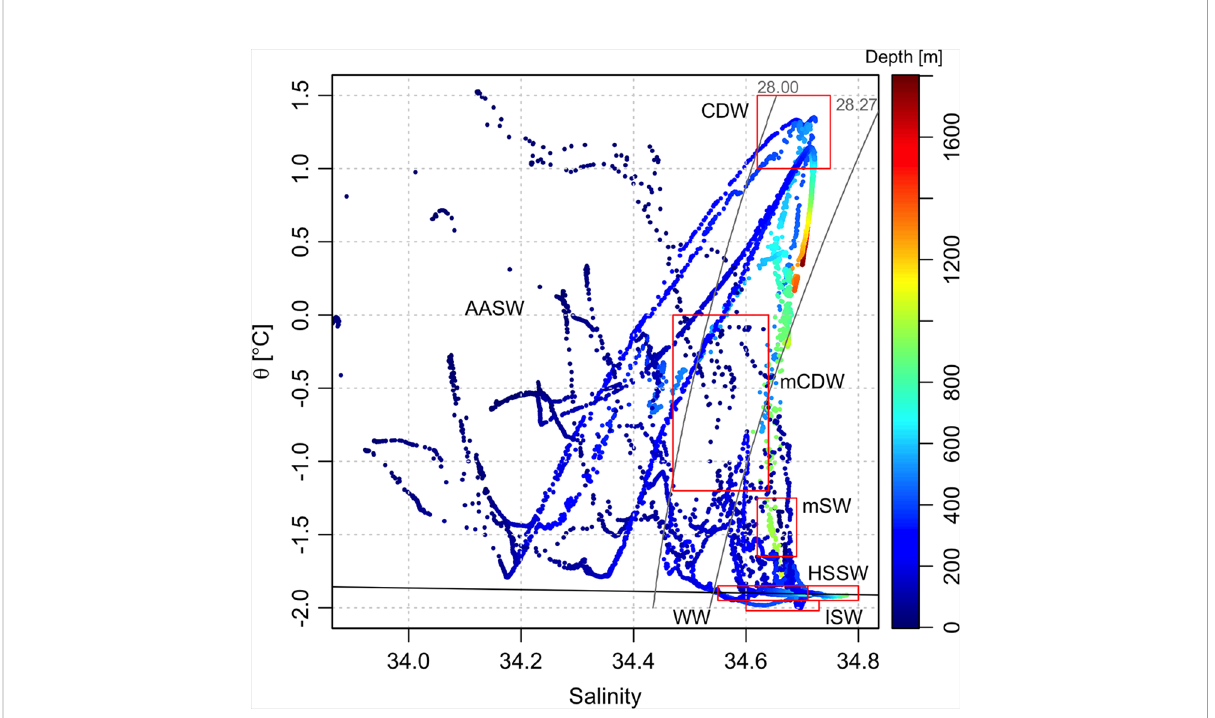
FIGURE 2 Potential temperature/salinity ( q /S) plot for the sampled stations. Grey solid lines show the 28.00 and 28.27 kg m − 3 neutral density anomaly ( g n ). The black horizontal line shows the surface freezing point of seawater. The color scale bar refers to the sampling depth. Major water masses are labeled as follows: Antarctic Surface Water (AASW), Circumpolar Deep Water (CDW), modi fi ed Circumpolar Deep Water (mCDW), High Salinity Shelf Water (HSSW), Ice Shelf Water (ISW), modi fi ed Shelf Water (mSW), and Winter Water